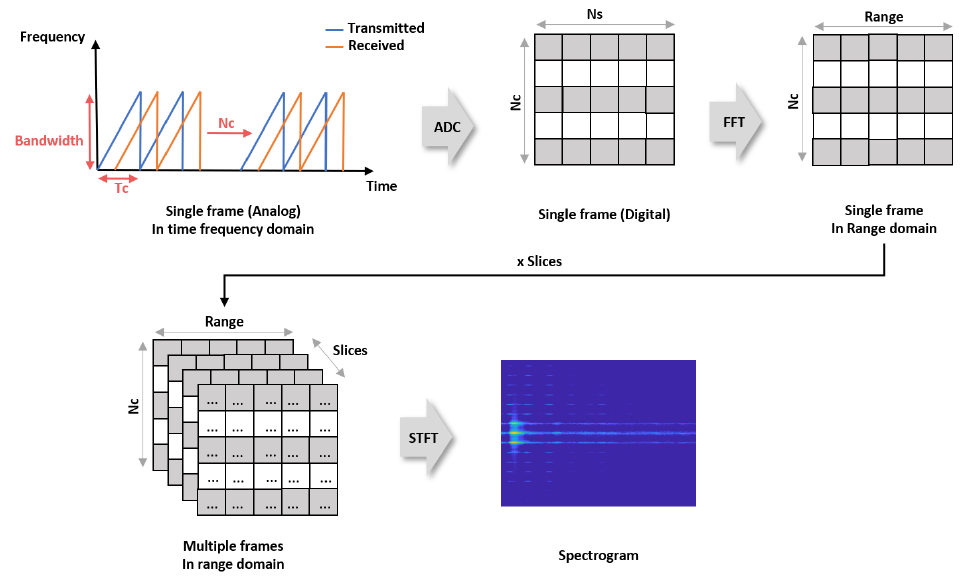
Figure 5. Data processing